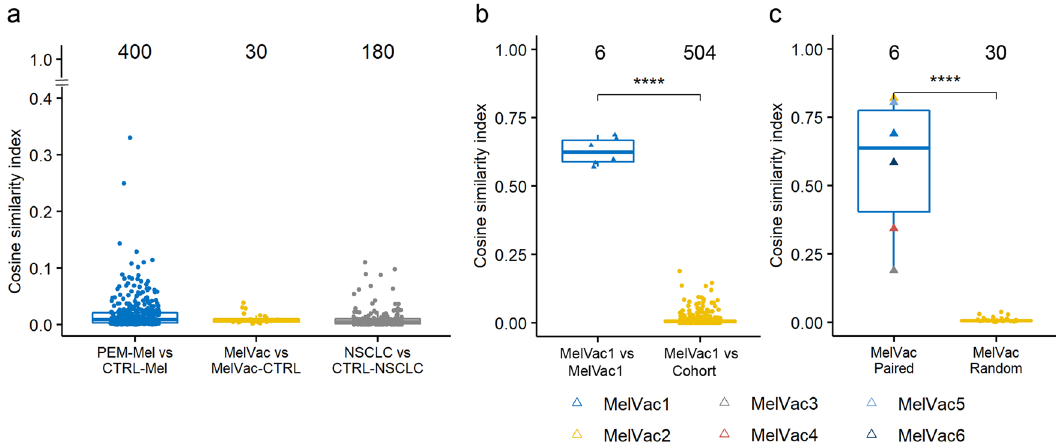
Fig. 1 Top antibody response is individual-speci fi c. a – c The top antibody response was analyzed using cosine similarity indices (CSI) by comparing the composition and abundance values of the 2500 most IgG-bound peptides in each sample to that of the rest of the cohort in pairs (Supplementary Data 1). CSI values (range from 0 to 1, y- axis) between samples belonging to the indicated groups ( x- axis) are depicted. Numbers above boxplots indicate the number of comparison pairs shown as dots. Comparisons of samples to themselves (CSI = 1) are not depicted. Comparisons between different individuals are indicated with circles while, comparison of the samples of the same patient are indicated with triangles. a Pairwise comparison between study groups and their matched controls. PEM-Mel – melanoma patients receiving pembrolizumab treatment (n = 5); CTRL-Mel – healthy controls for melanoma group ( n = 80); MelVac – NSCLC patients who received MelCancerVac ® vaccine ( n = 6); MelVac-CTRL – paired samples of MelVac group taken before vaccination ( n = 6); NSCLC – non-small cell lung cancer patients ( n = 18); CTRL-NSCLC – non-cancer controls for NSCLC group ( n = 10). b Pairwise (Supplementary Table 2), to the 4 samples themselves ( MelVac1 vs MelVac1 ) and to the rest of the study cohort ( n = 126 samples, MelVac1 vs Cohort ). c Pairwise comparisons of pre- and post-vaccination immunopro fi les of vaccinated NSCLC patients ( n = 6). MelVac Paired – comparison of pre- and post- vaccination samples of the same patient; MelVac Random - comparison of the pre-vaccination sample of one patient to the post-vaccination samples of all 5